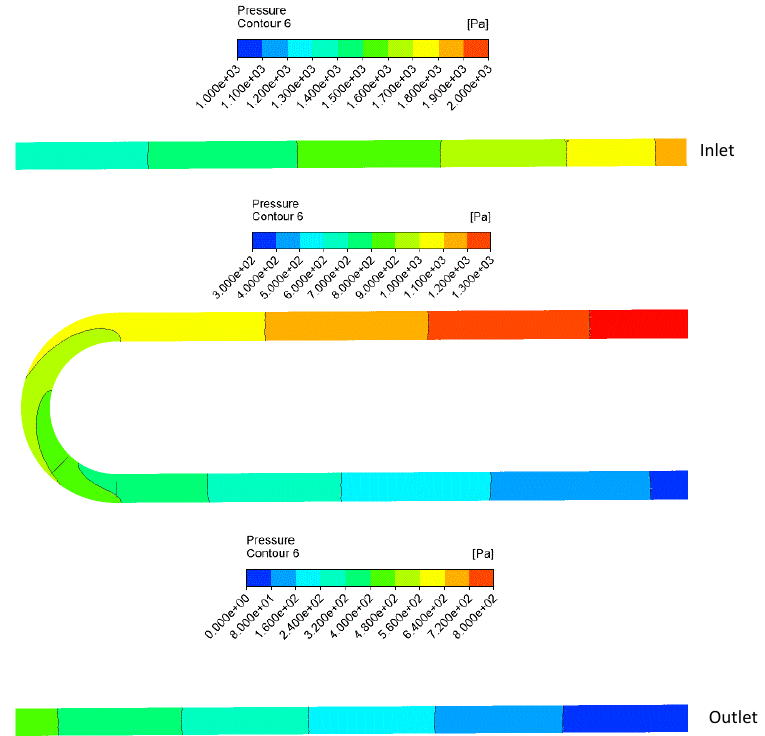
Figure 13. Pressure contour distribution along the inlet, curvature and outlet sections using fruit juice.